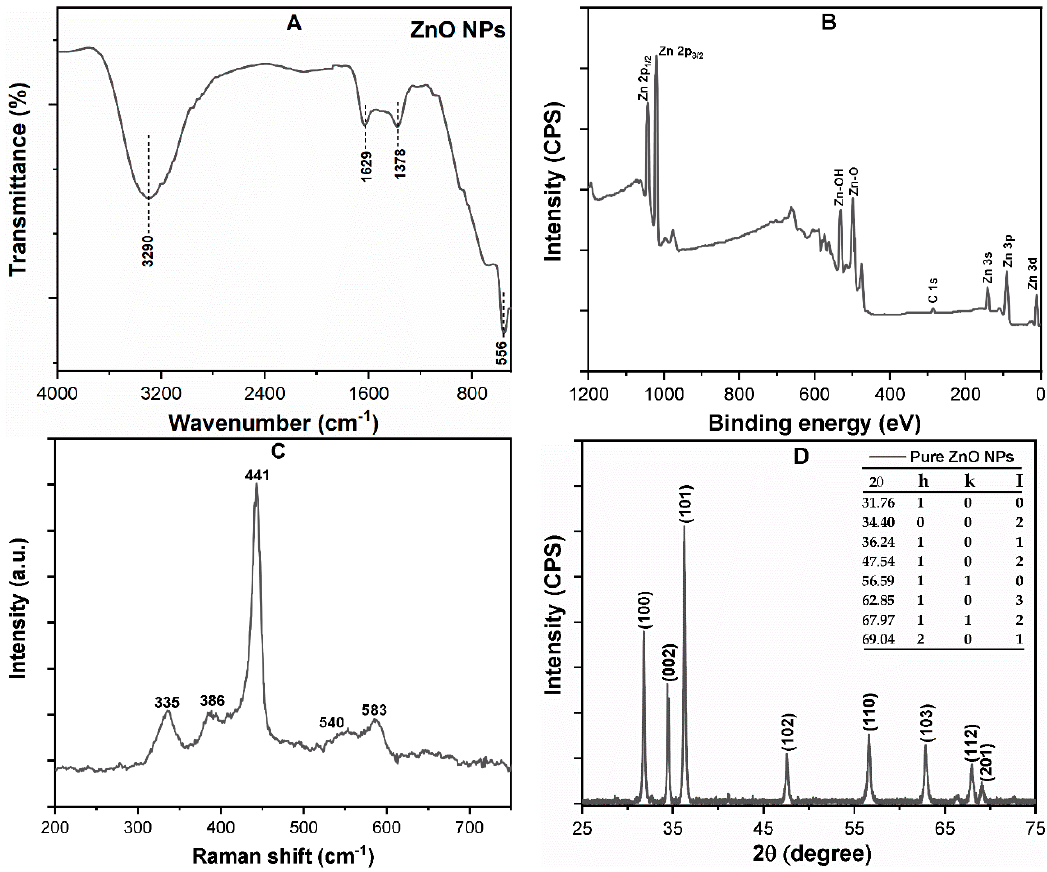
Figure 1. Characterization of the zinc oxide nanoparticles (ZnO NPs) powder ( A ) FT-IR; ( B ) X-ray photoelectron spectroscopy (XPS) survey spectrum; ( C ) Raman spectrum; ( D ) XRD spectra expressed in arbitrary units and counts per second.